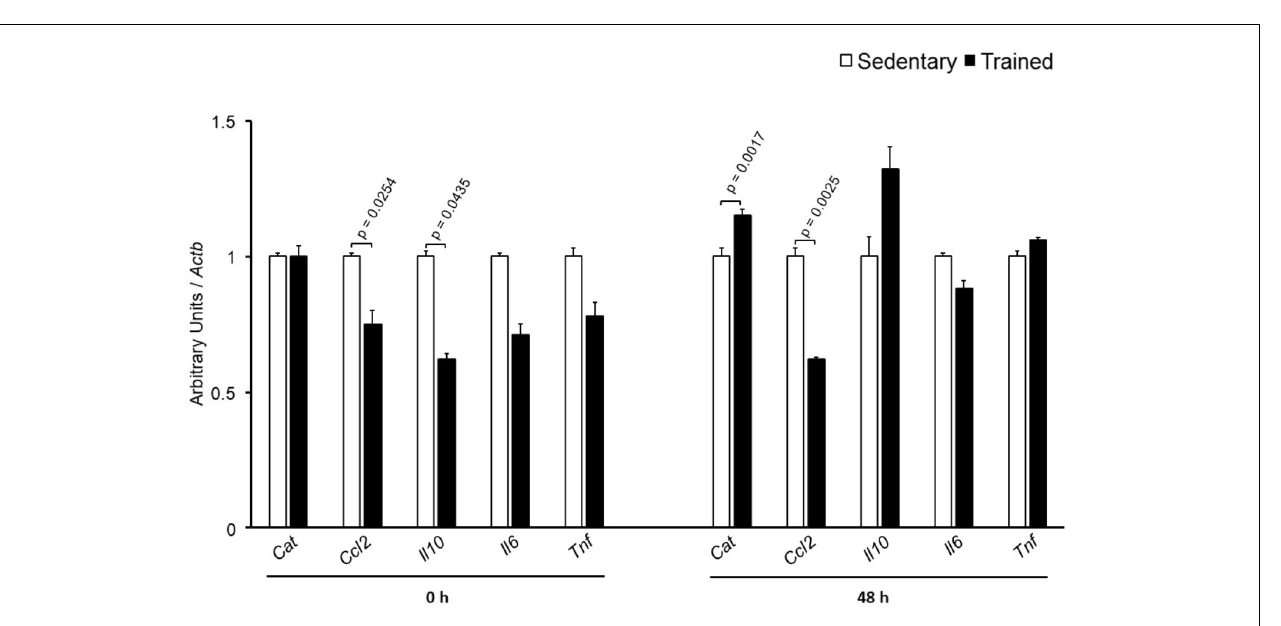
units, related to mean of the sedentary animal, which was set as